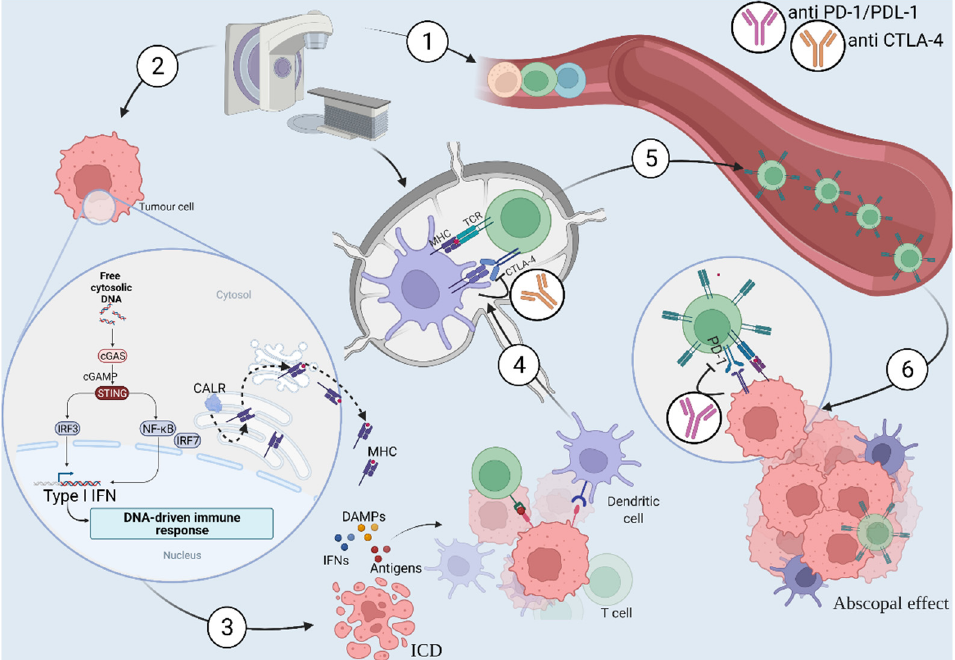
Figure 1. (1) Radiotherapy leads to tissue damage, including immune cell depletion. (2) Radiotherapy has a direct cytotoxic effect on tumour cells inducing DNA damage leading to activation of the cGAS/STING pathway resulting in: (3) immunological cell death (ICD) and activation of inflammatory signals including the release of tumour-associated antigenic peptides (antigens), damage-associated molecular patterns (DAMPs), calreticulin (CALR) expression and major histocompatibility class I (MHC I) surface expression. This up-regulation leads to activation of dendritic cells (DCs) that (4) migrate to lymph nodes resulting in antigen presentation and subsequent (5) priming of tumour-specific T cell and proliferation. (6) Primed T-cells then attack tumours located within the irradiated field and in distant locations (abscopal effect). This response can be enhanced by addition of immune checkpoint inhibitors (ICIs) such as anti PD-1/PDL-1 and anti CTLA-4 agents to counteract the immunosuppressive effect of Radiotherapy.